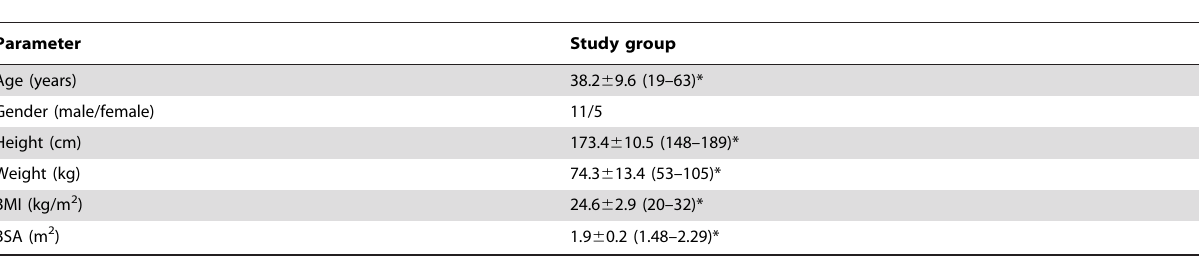
Table 1. Patient